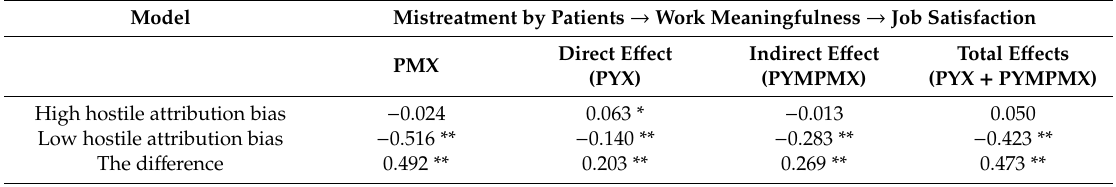
Table 4. Direct, indirect, and total e ff ects at di ff erent levels of hostile attribution bias.